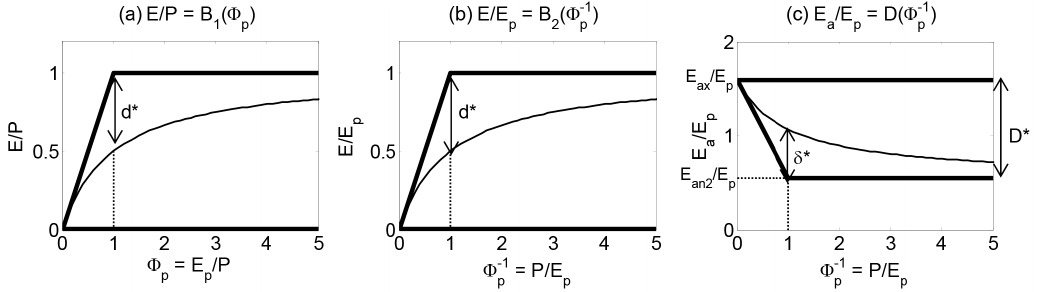
Figure 2. Correspondence between the two forms of the Turc–Mezentsev functions ( E/P = B 1 ((cid:56) p ) and E/E p = B 2 ((cid:56) − 1 p ) given by Eqs. 4 and 5) and the function defining the drying power of the air ( E a /E p = D((cid:56) − 1 p ) given by Eq. 10). The calculations are made with b = 1, λ = 1 and a temperature of 15 ◦ C: d ∗ = 0 . 50, D ∗ = 1 . 05 and δ ∗ = 0 . 52. The bold lines indicate the limits of the feasible